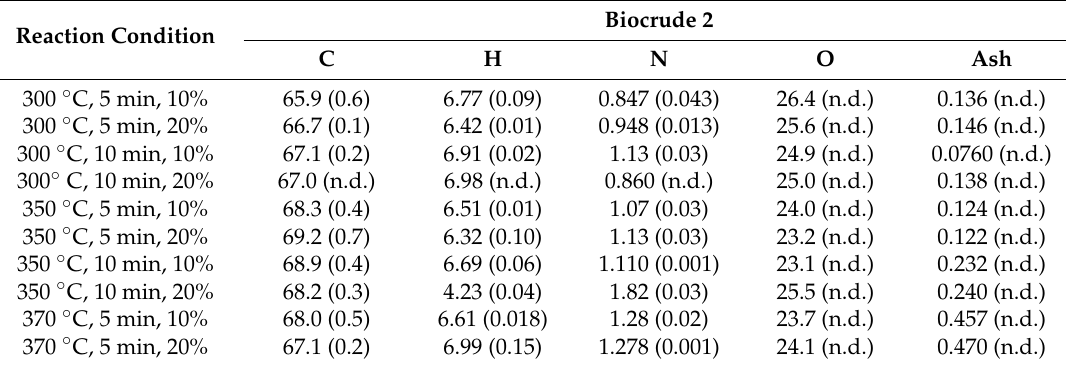
Table A4. Elemental composition of heavy biocrude fraction (% w / w , as received). Absolute standard deviation, where available, is reported in brackets.